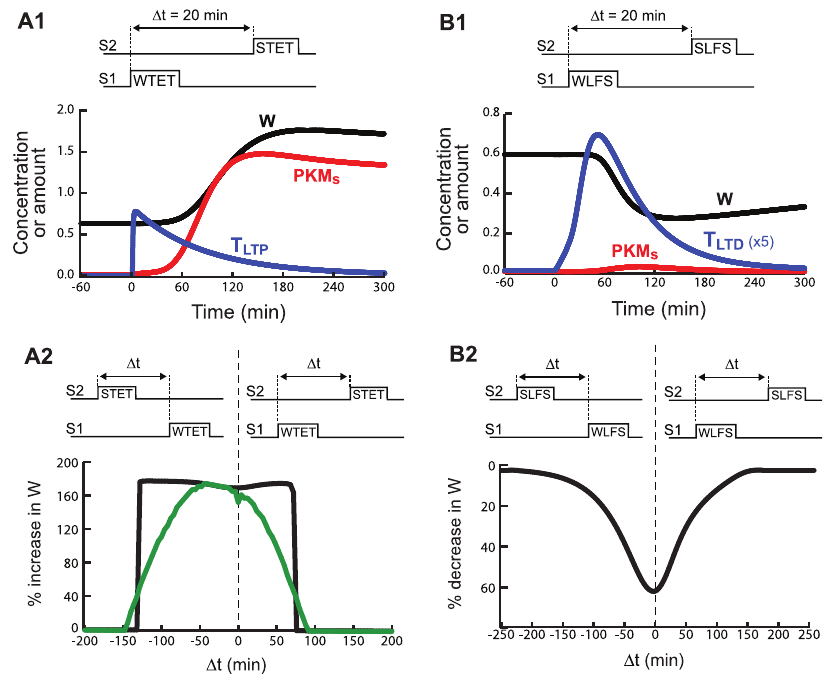
Figure 5. Simulation of STC. A1 , WTET is delivered to S1 followed by STET to S2 (20 min interstimulus interval, onset to onset). Synaptic variables are for S1, at which LTP occurs. A2 , STC is effective during a limited time window. The x -axis represents time between the beginning of the STET and WTET. A negative D t indicates that STET precedes WTET. The y -axis represents the percent change of W at S1, assessed 5 h after WTET to S1. 5 h sufficed for LTP to approach its steady-state value. Black curve, time window for a single synaptic compartment coupled to a dendritic compartment. Green curve, time window for a population of 40 compartment pairs. Over the 40 pairs, the value of the rate constant k d R s increased in uniform steps from 25% to 125% of its standard value of 0.0025 min 2 1 . B1 , WLFS is delivered to S1 20 min prior to SLFS at S2. If WLFS is followed by SLFS, LTD occurs. B2 , STC for LTD occurs during a limited time window. LTD is assessed 3 h after the second of the paired stimuli.